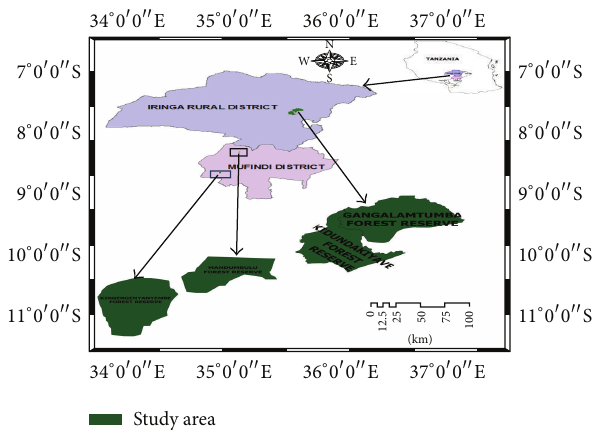
Figure 1: Map showing the location of the study areas and the respective forest